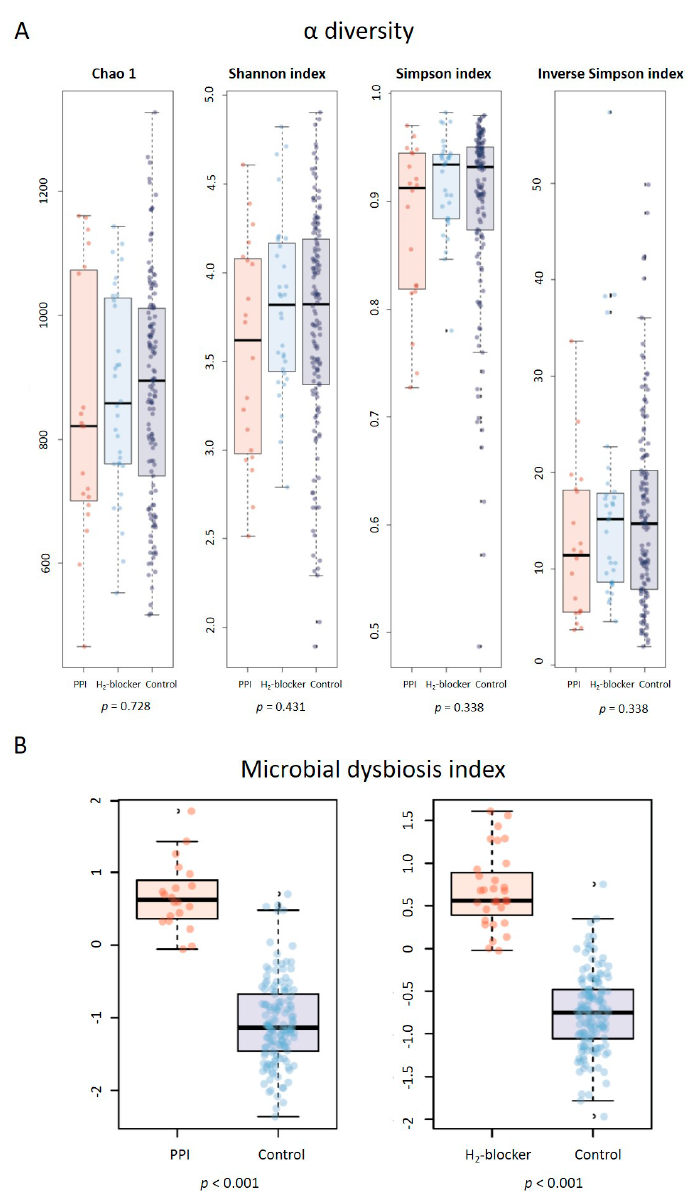
Figure 1. The α -diversity and microbial dysbiosis index in hemodialysis patients with proton pump inhibitor (PPI) users, H 2 -blocker users, and controls: ( A ) no difference in richness (Chao 1 index) or evenness (Shannon index, Simpson index, Inverse Simpson index); ( B ) proton pump inhibitor users or H 2 -blocker users had a higher microbial dysbiosis index compared to the controls.